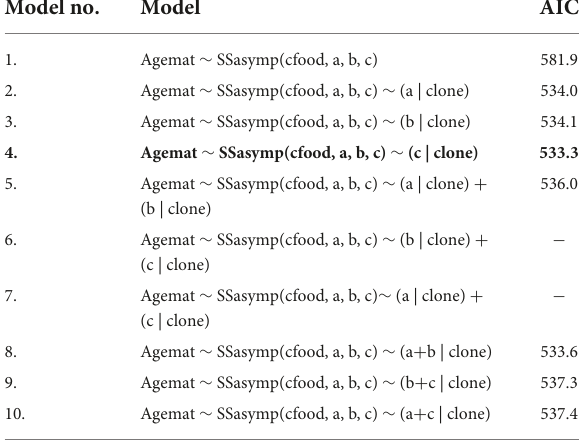
TABLE 2 Age at maturity reaction norm models, fitted using random regression mixed models (RRMM). Model